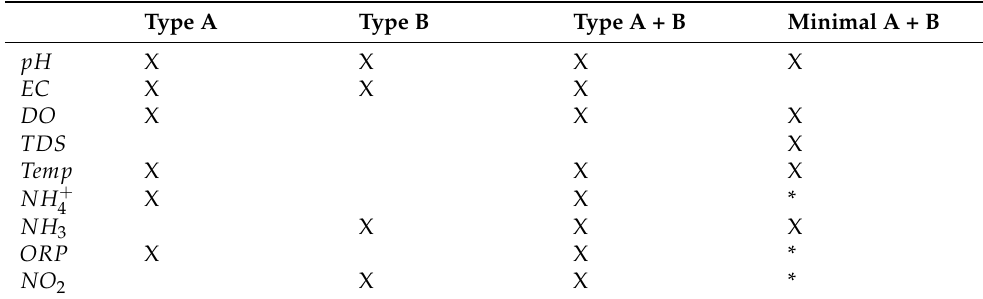
Table 3. Sensor Types and Monitoring Parameters.